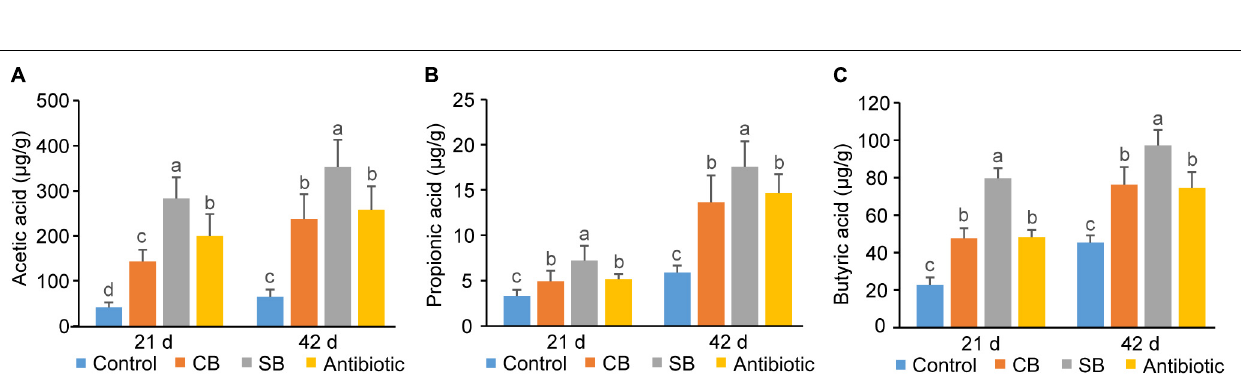
FIGURE 4 | SCFAs concentrations in broiler ileum chyme. (A) Acetic acid. (B) Propionic acid. (C) Butyric acid. SCFAs concentrations are expressed in microgram per gram of chyme sample ( µ g/g). Significant differences are shown by bars labeled with various letters.